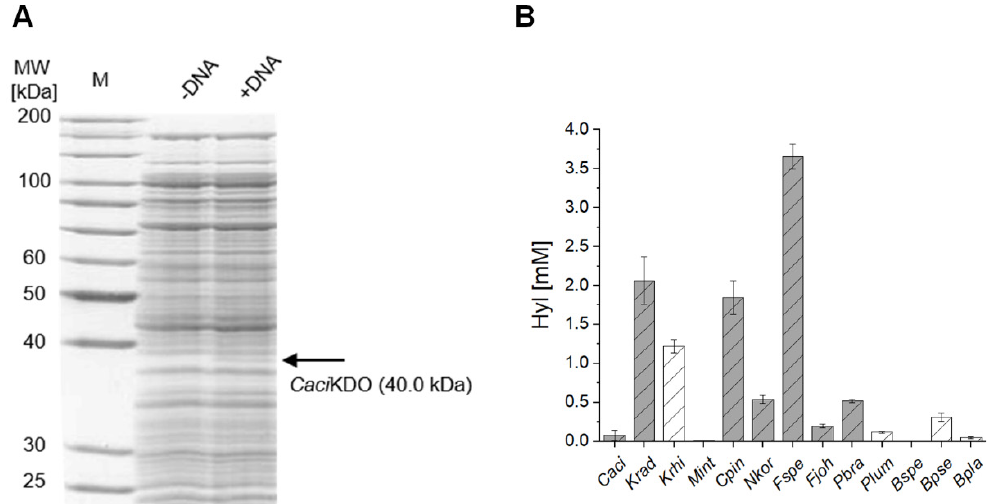
Figure 4. ( A ) SDS-PAGE gel image of cell-free synthesized Caci KDO. M, marker; -DNA, CFPS mix without plasmid template; +DNA, CFPS mix containing the plasmid template for Caci KDO. ( B ) Hydroxy- L -lysine (Hyl) concentrations achieved in in vitro hydroxylation assays for cell-free synthesized KDOs ( Caci , Catenulispora acidiphila ; Krad , Kineococcus radiotolerans , Krhi , Kineococcus rhizosphaerae ; Mint , Mycobacterium interjectum ; Cpin , Chitinophaga pinensis ; Nkor , Niastella koreensis ; Fspe , Flavobacterium sp.; Fjoh , Flavobacterium johnsoniae ; Pbra , Polyangium brachysporum ; Plum , Photorhabdus luminescens ; Bspe , Burkholderia sp. MSMB617WGS; Bpse , Burkholderia pseudomallei ; Bpla , Burkholderia plantarii ). Assays were performed on a 100 µL scale with 10 mM L -lysine (Lys) and 20% v/v protein solution for 20 h. Protein homologs are sorted by phylogenetic distance. Grey bars indicate described KDOs, while white bars indicate undescribed KDOs. Error bars are a result of biological duplicates.